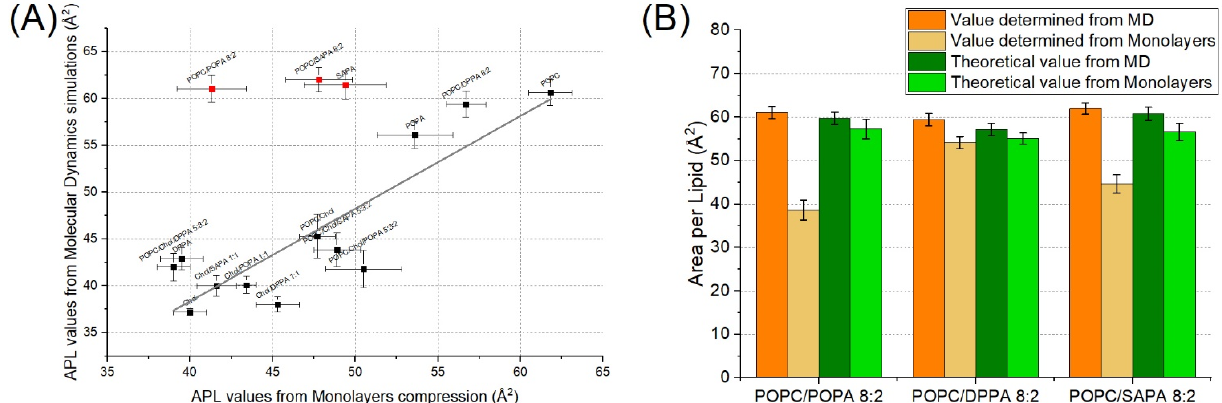
Figure 3. ( A ) Linear correlation of APL values from monolayer and molecular dynamics systems. ( B ) Effect of PA on POPC membranes showed with determined values of APL for POPC/PA systems for both simulation and experimental approaches. Theoretical values were determined based on values from single-component systems multiplied by factor corresponding to molar concentration on the membrane (Equation (3)).